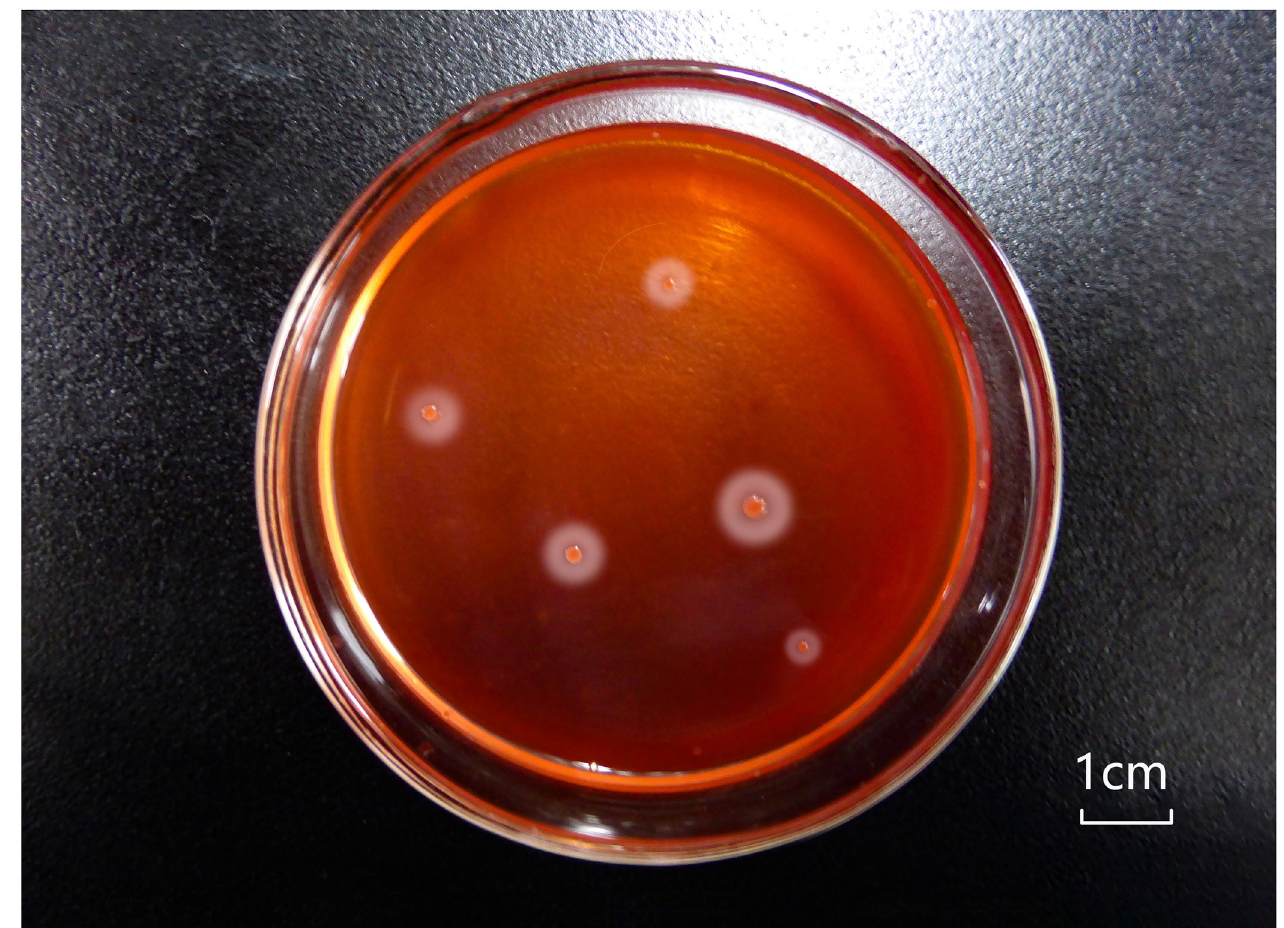
Fig 4. Characteristic of C . sartagoforme XN-T4 on Congo-CMC.